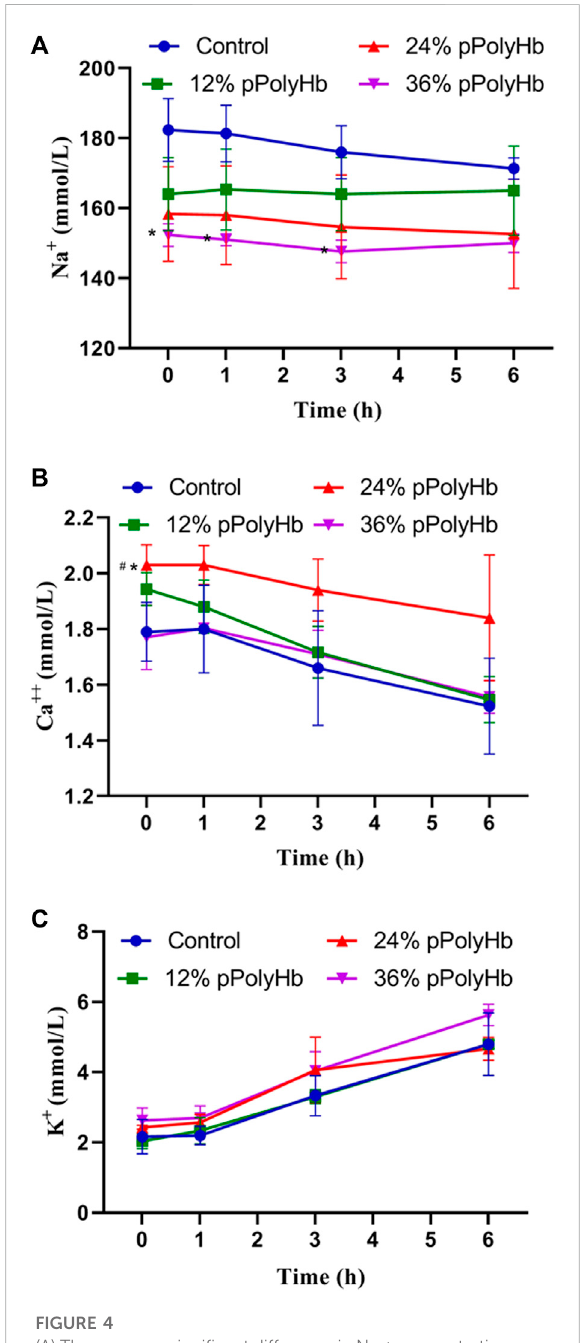
FIGURE 4 (A) There was no signi fi cant difference in Na + concentration among the four groups during perfusion (B) After 1 h of perfusion, Ca2+ in the four groups showed a downward trend, and after the endofperfusion,Ca2+inthe24%pPolyHbgroupwasslightly higher than that in the other three groups (C) There was no signi fi cant difference in K+ concentration among the four groups, and it increased at any time (Note: * stands for comparison with the control group, # stands for comparison with 36% pPolyHb, * p < 0.05, #